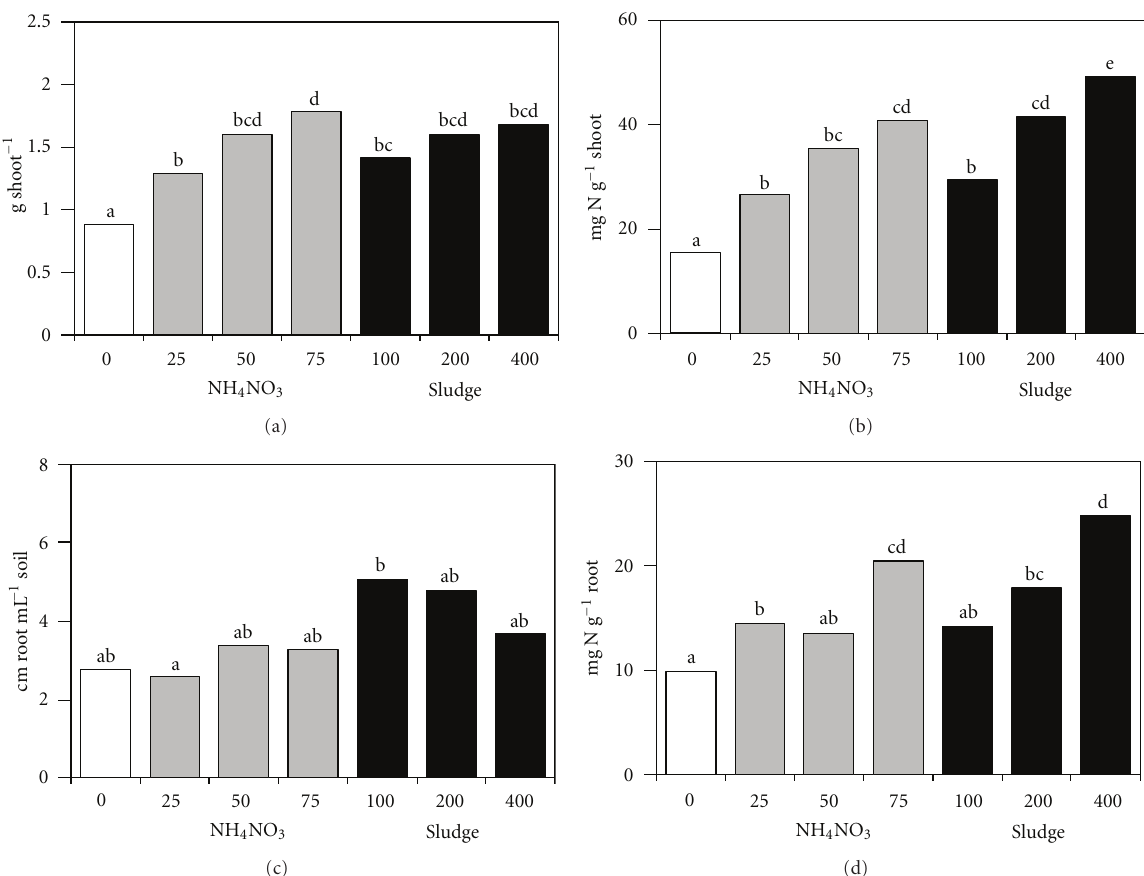
Figure 5: Greenhouse experiment. (a) Shoot dry mass, (b) shoot N concentration, (c) root length density, and (d) root N concentration after 24 days of growth for pots amended with ammonium nitrate or sludge at rates shown in mg Nkg − 1 dry soil. Controls received no amendment. Means with di ff erent letters (a, b, c, d, and e) are significantly di ff erent at the 5% probability